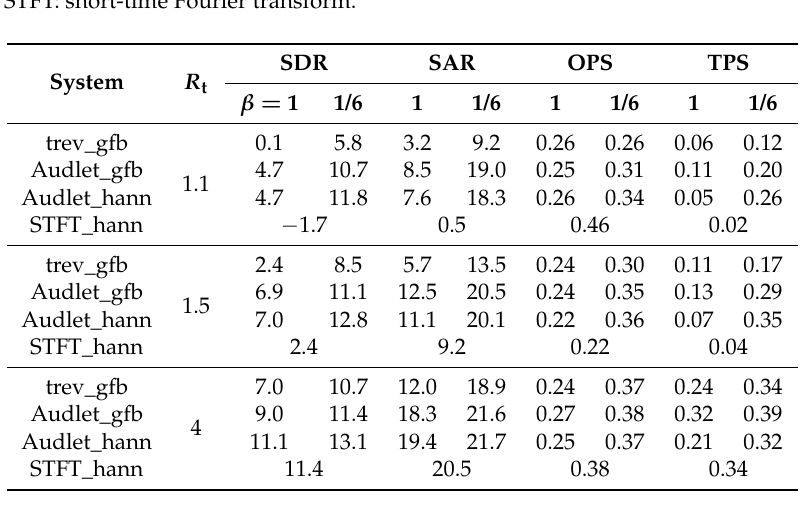
Table 3. Objective quality measures for the separated voice signal. The signal-to-distortion ratio (SDR) and signal-to-artifact ratio (SAR) are in dB; the larger the ratio, the better the separation result. Overall perceptual score (OPS) and target perceptual score (TPS) are without unit; they indicate scores between 0 (bad quality) and 1 (excellent quality). The corresponding audio files are available on the companion webpage. STFT: short-time Fourier